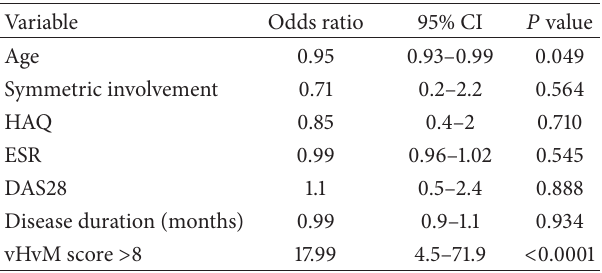
Table 4: Logistic regression including van der Helm-van Mil score as a dichotomous